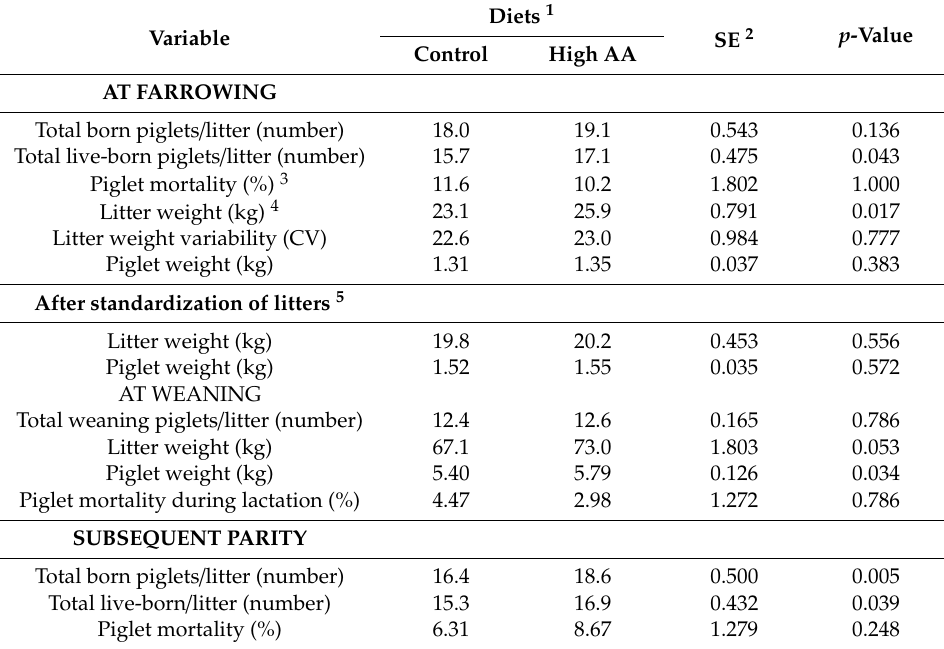
Table 3. E ff ect of the dietary amino acid (AA) concentration from day 77 to 107 of gestation on productive performances in hyperprolific multiparous